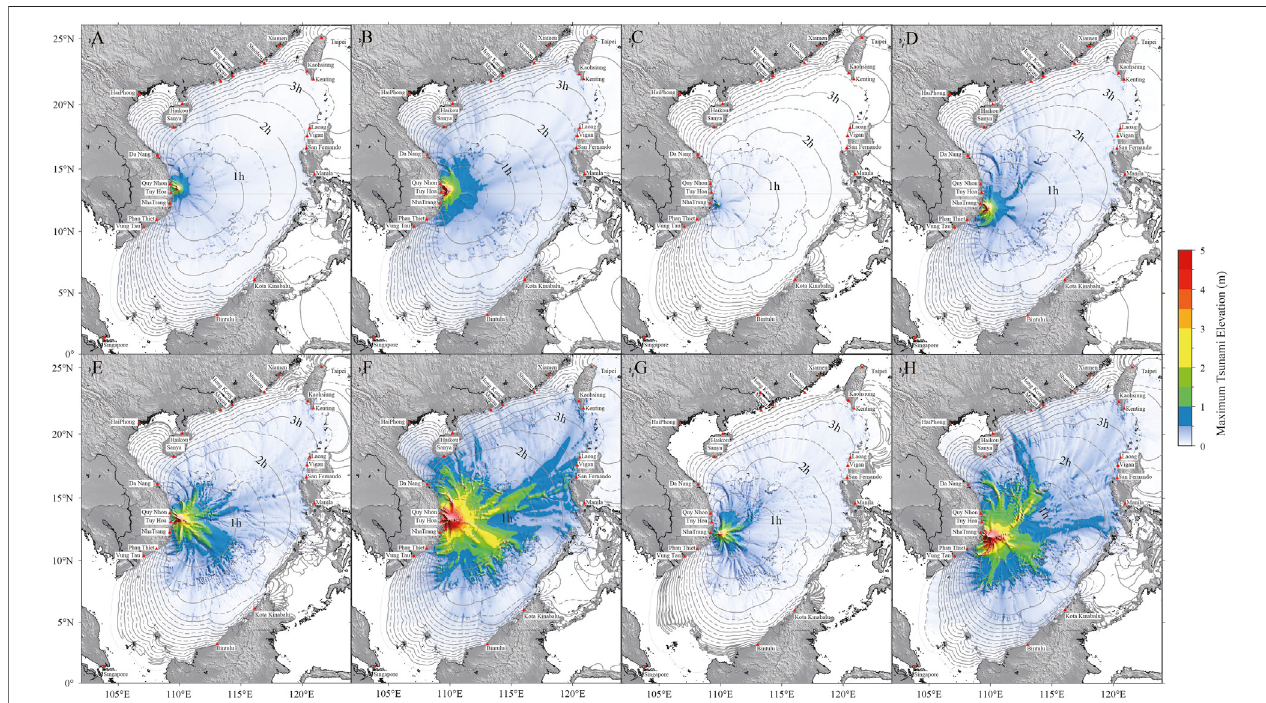
FIGURE10 | The distributions ofmaximum surface elevation and tsunami arrival time generated by (A – D) deformable slides ofLS01-LS04 and (E – H) rigid slumps of LS01-04.